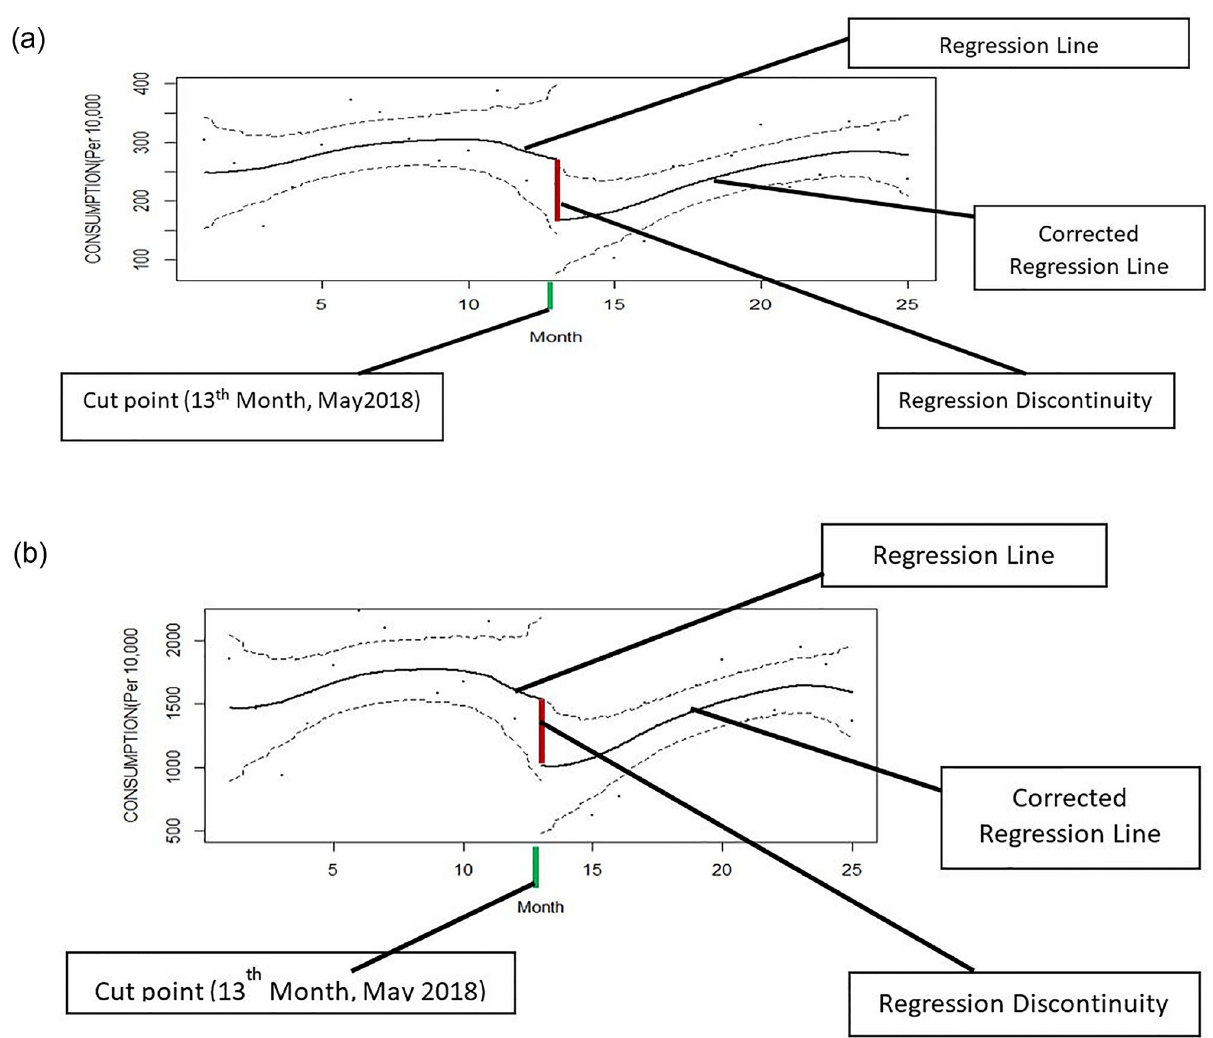
Fig 2. Effect of an intervention based on regression discontinuity design. A] Sales volume, B] Define daily dose (DDD).